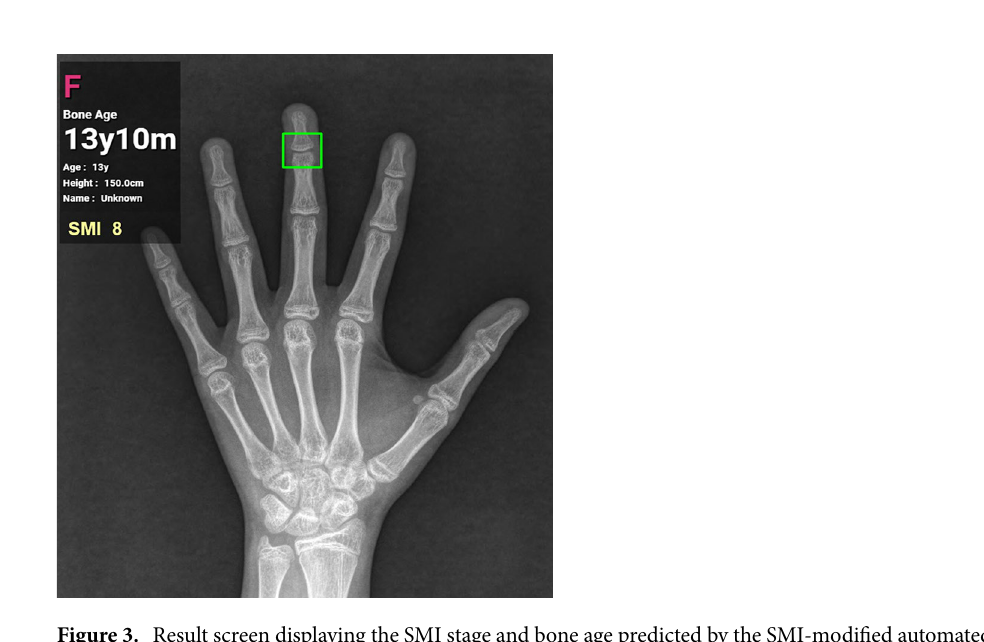
Figure 3. Result screen displaying the SMI stage and bone age predicted by the SMI-modified automated skeletal maturation assessment